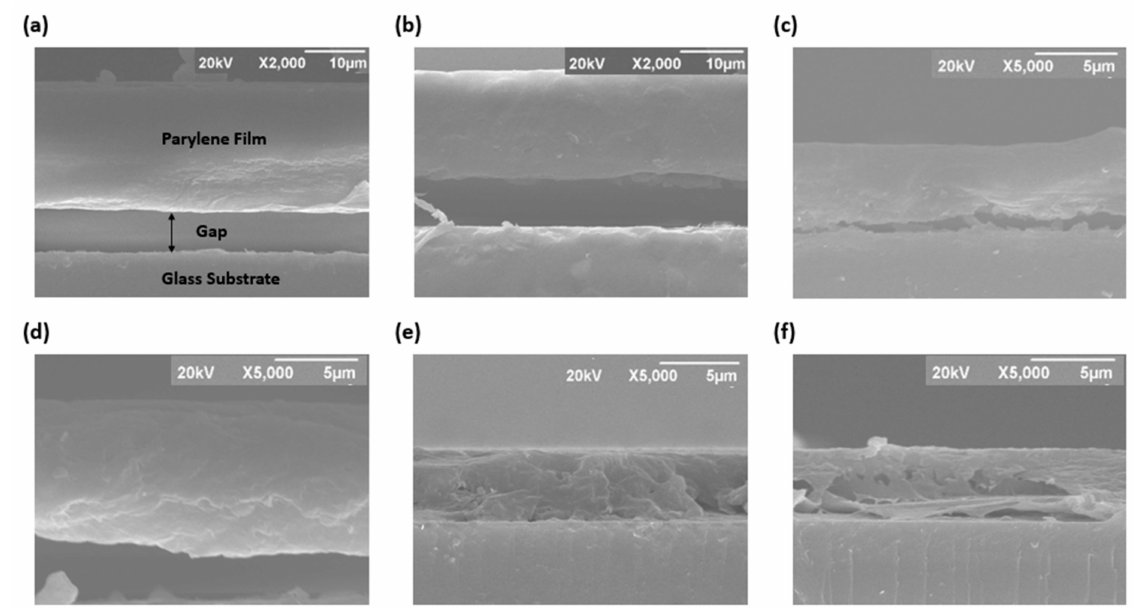
Figure 4. Cross-sectional SEM image. ( a ) Pristine parylene-C. ( b ) 90 ◦ C annealed parylene-C for 120 min. ( c ) Parylene-C/AlN 30 min. ( d ) Parylene-C/AlN 45 min. ( e ) Parylene-C/AlN 90 min. ( f ) Parylene-C/AlN 120